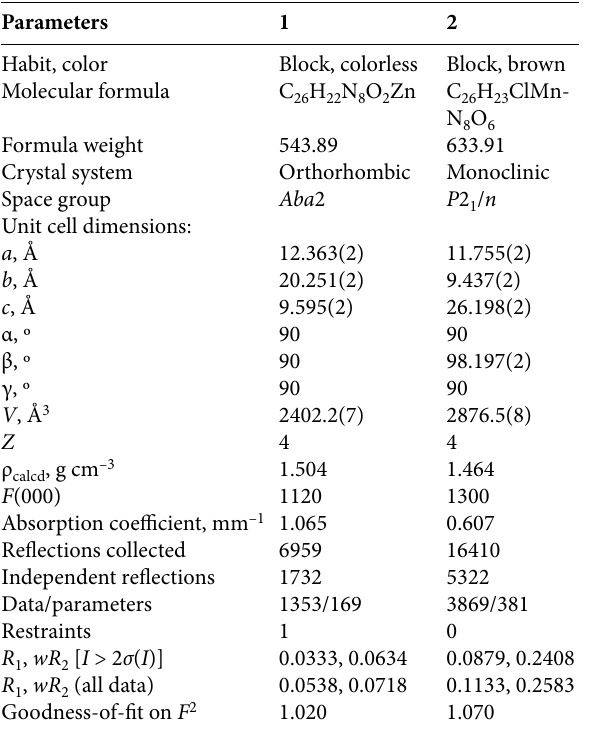
Table 1. Crystallographic data and refinement parameters for com- plexes 1 and